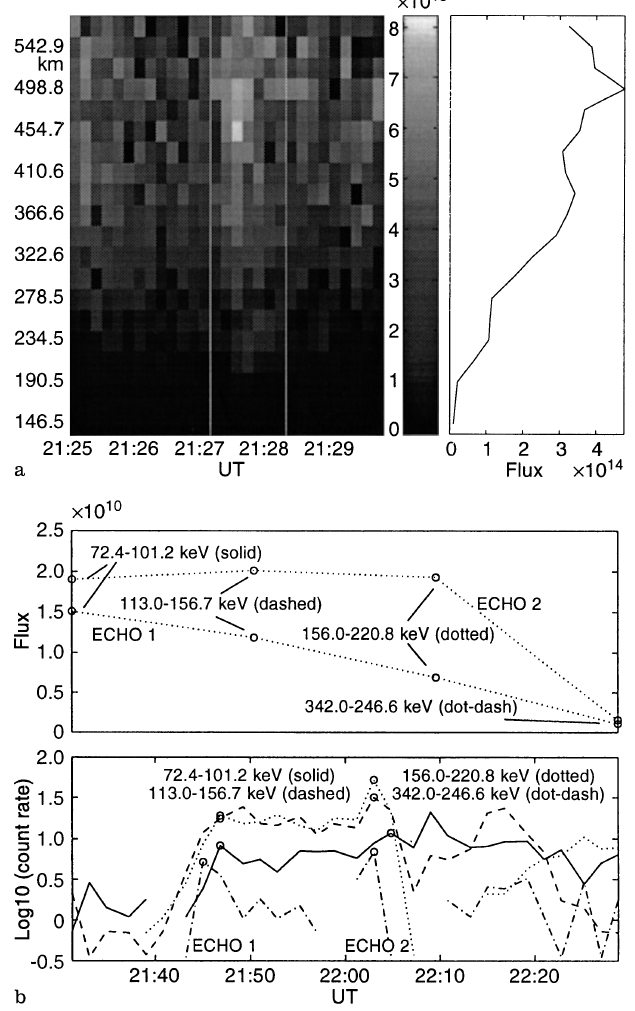
Fig. 10. a The upward flux of ionospheric ions, as measured by EISCAT during transition of the arc through the EISCAT beam at ) as a function about 21 (cid:50)(cid:55) UT. The left - hand panel shows flux ( n (cid:101) (cid:93) v (cid:69) of altitude and UT, with the interval containing the arc bounded by two white lines. Immediately to its right is a scale showing flux values. The right - hand panel shows the altitude profile of flux integ- rated over this time interval (roughly 21 (cid:50)(cid:55) — 21 (cid:50)(cid:56) ) spanned by the two white lines. b O (cid:96) -ion flux measured by MICS during the two primary injections (echos 1 and 2) that are visible in Fig. 5. The bottom panel shows the uncorrected count rates (120-s averages) in four energy ranges selected by averaging over a number of the available 32 energy steps. The circles represent the points which lie along the dispersed echo. These are used in the calculation of the actual flux which is shown in the top panel